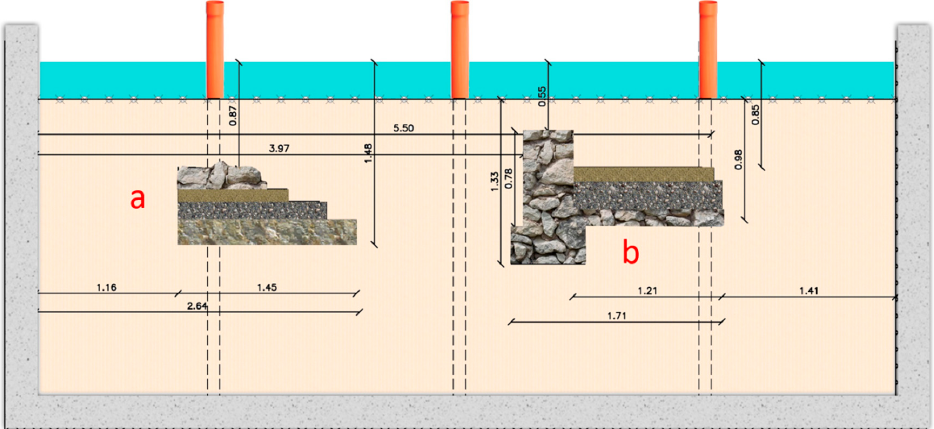
Figure 3. Transversal section realized on the line S1 with an indication of the size and depth of the buried objects.